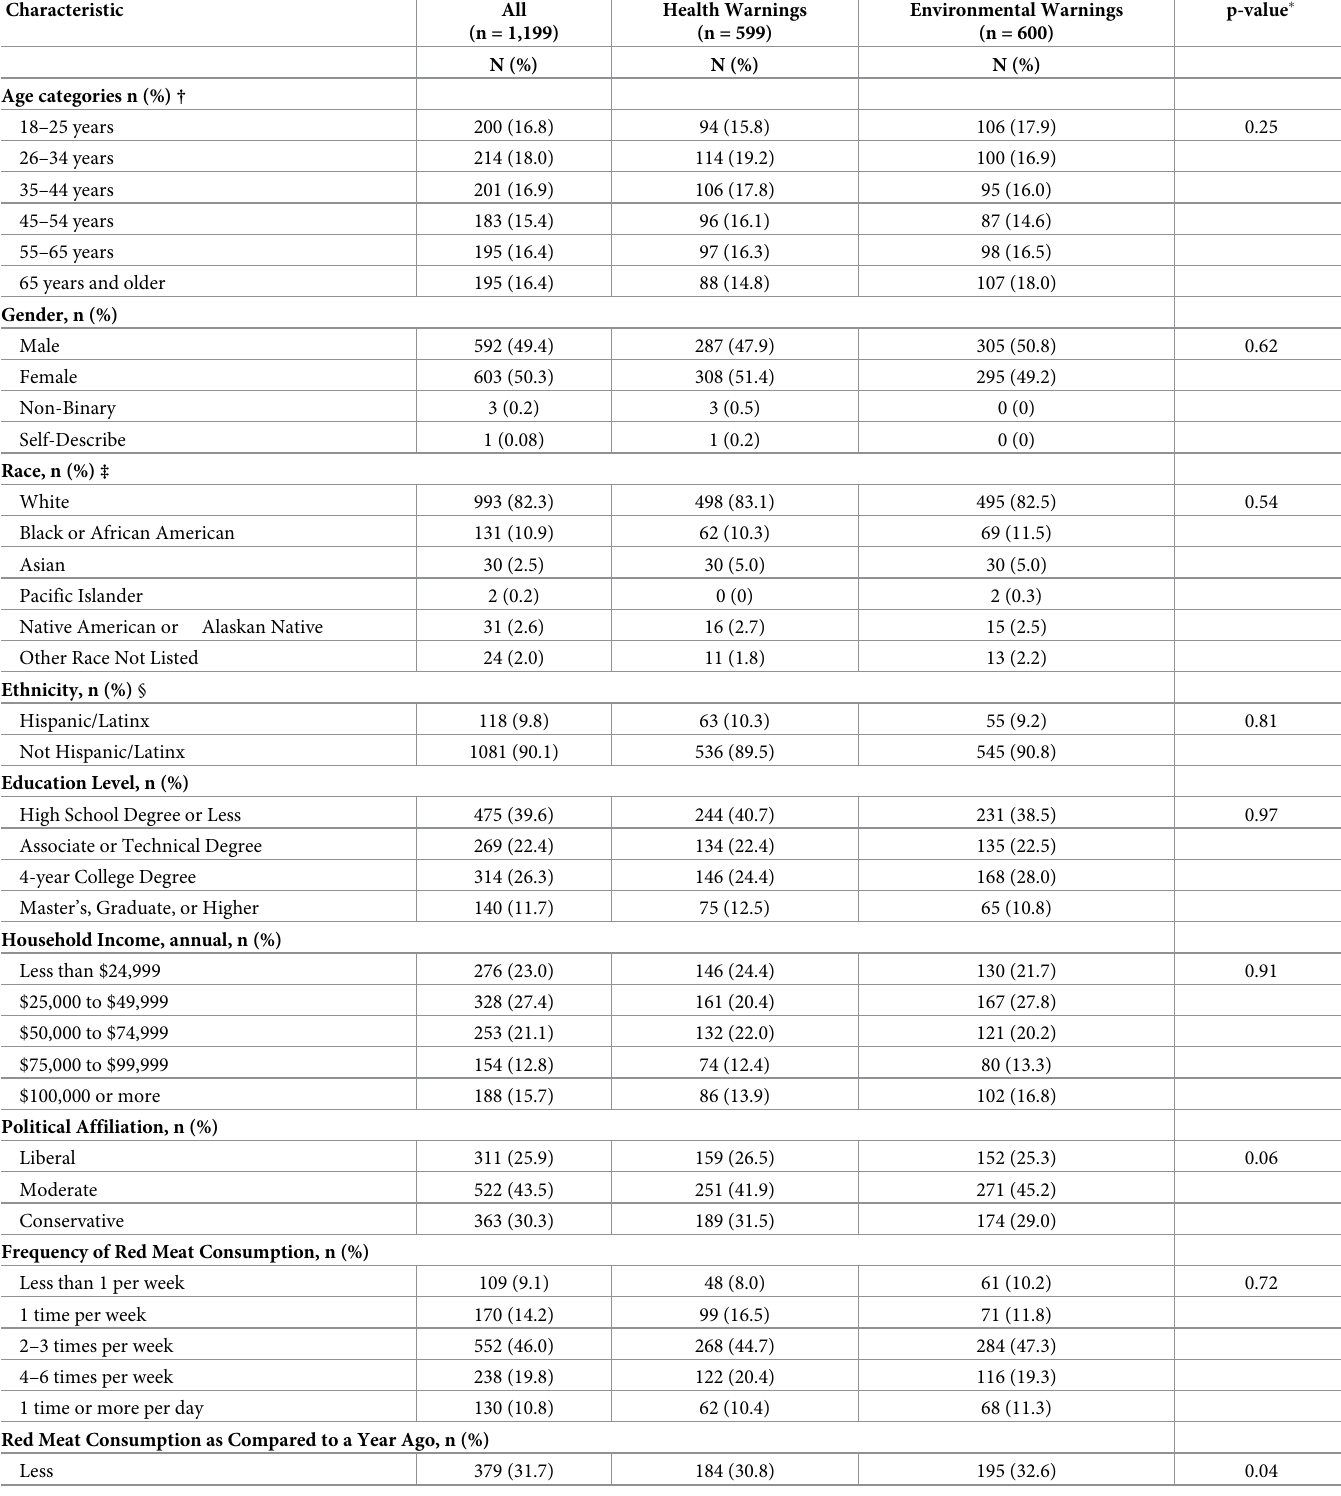
Table 3. Characteristics of participants in online experiment of health and environmental warning messages for red meat ( n = 1,199) from March 2020 in the United States.